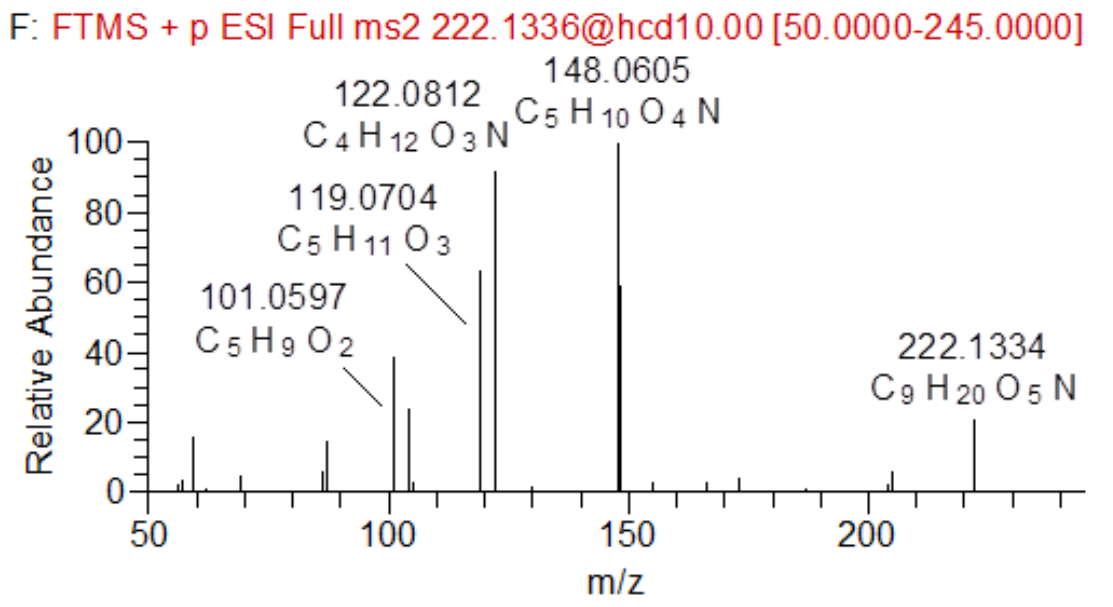
Figure 3. Orbitrap-ESI-MS 2 spectra of Figure 3. Orbitrap - ESI-MS 2 spectra of TRIS-IBCF.